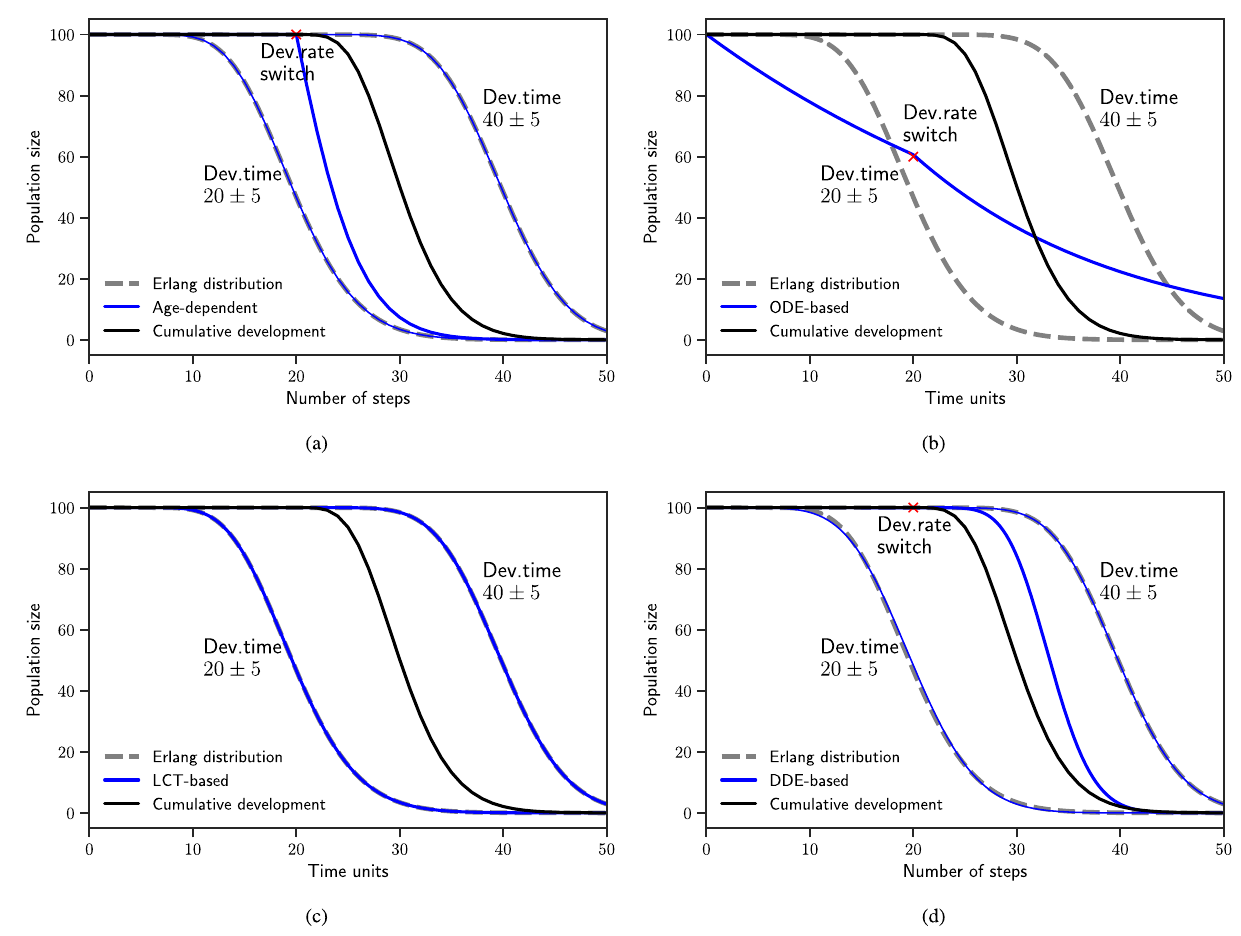
Figure 1. Response to change in development time. The number of developing individuals is simulated by using the cumulative development process and compared to ( a ) the age-dependent development process, ( b ) an ODE representation, ( c ) an LCT representation, and ( d ) a DDE representation. Solid dark lines show the cumulative development and thick blue lines show the alternative models. Dashed gray lines mark the two target trajectories before and after the shift in development time (marked with red